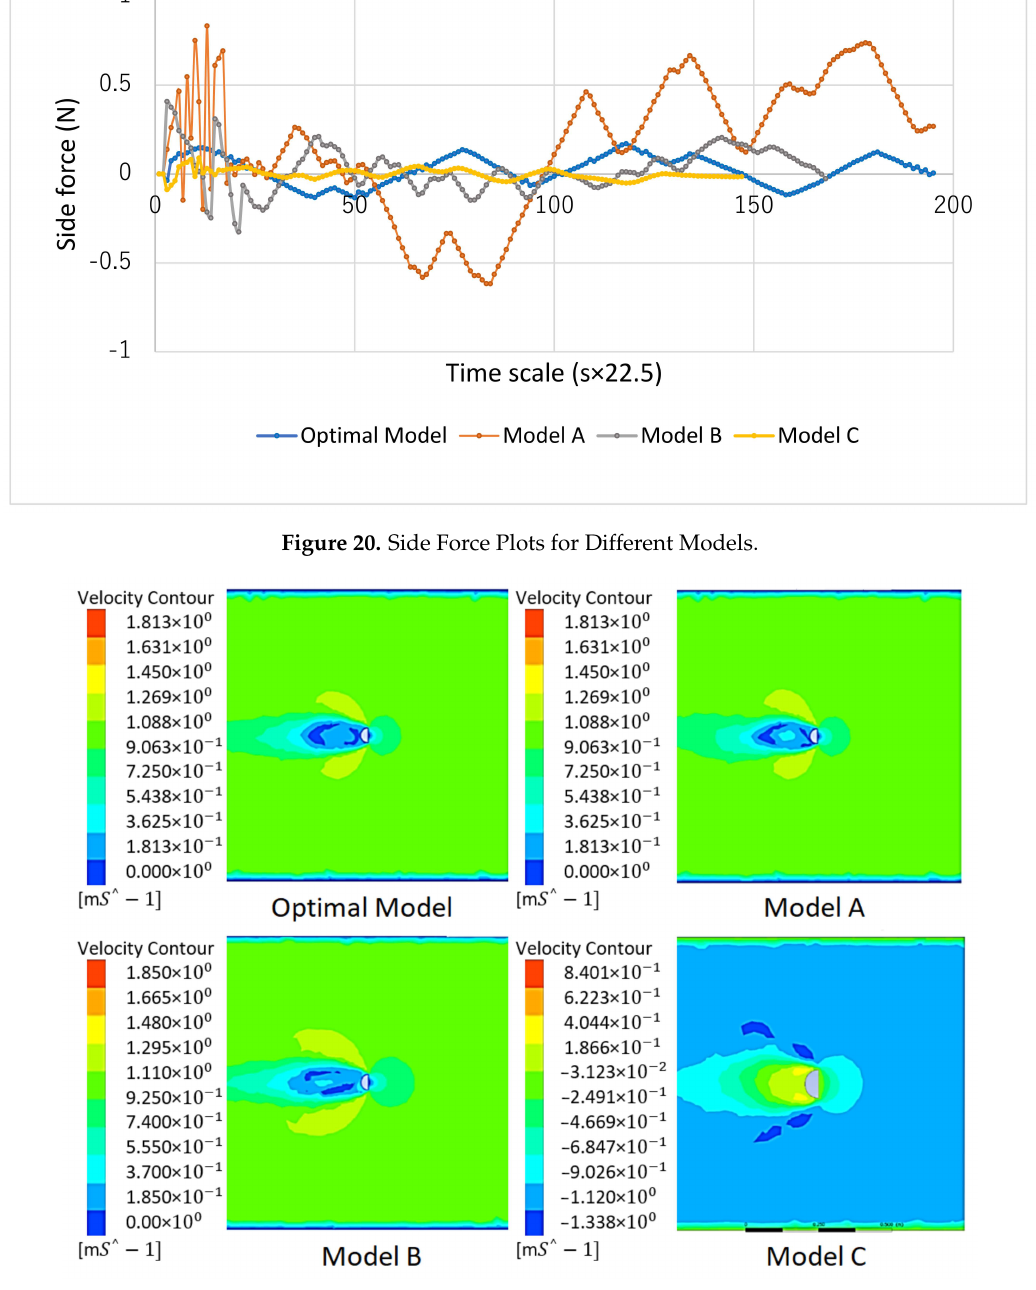
Figure 21. Velocity Contours for the Optimal Model and Models A, B and